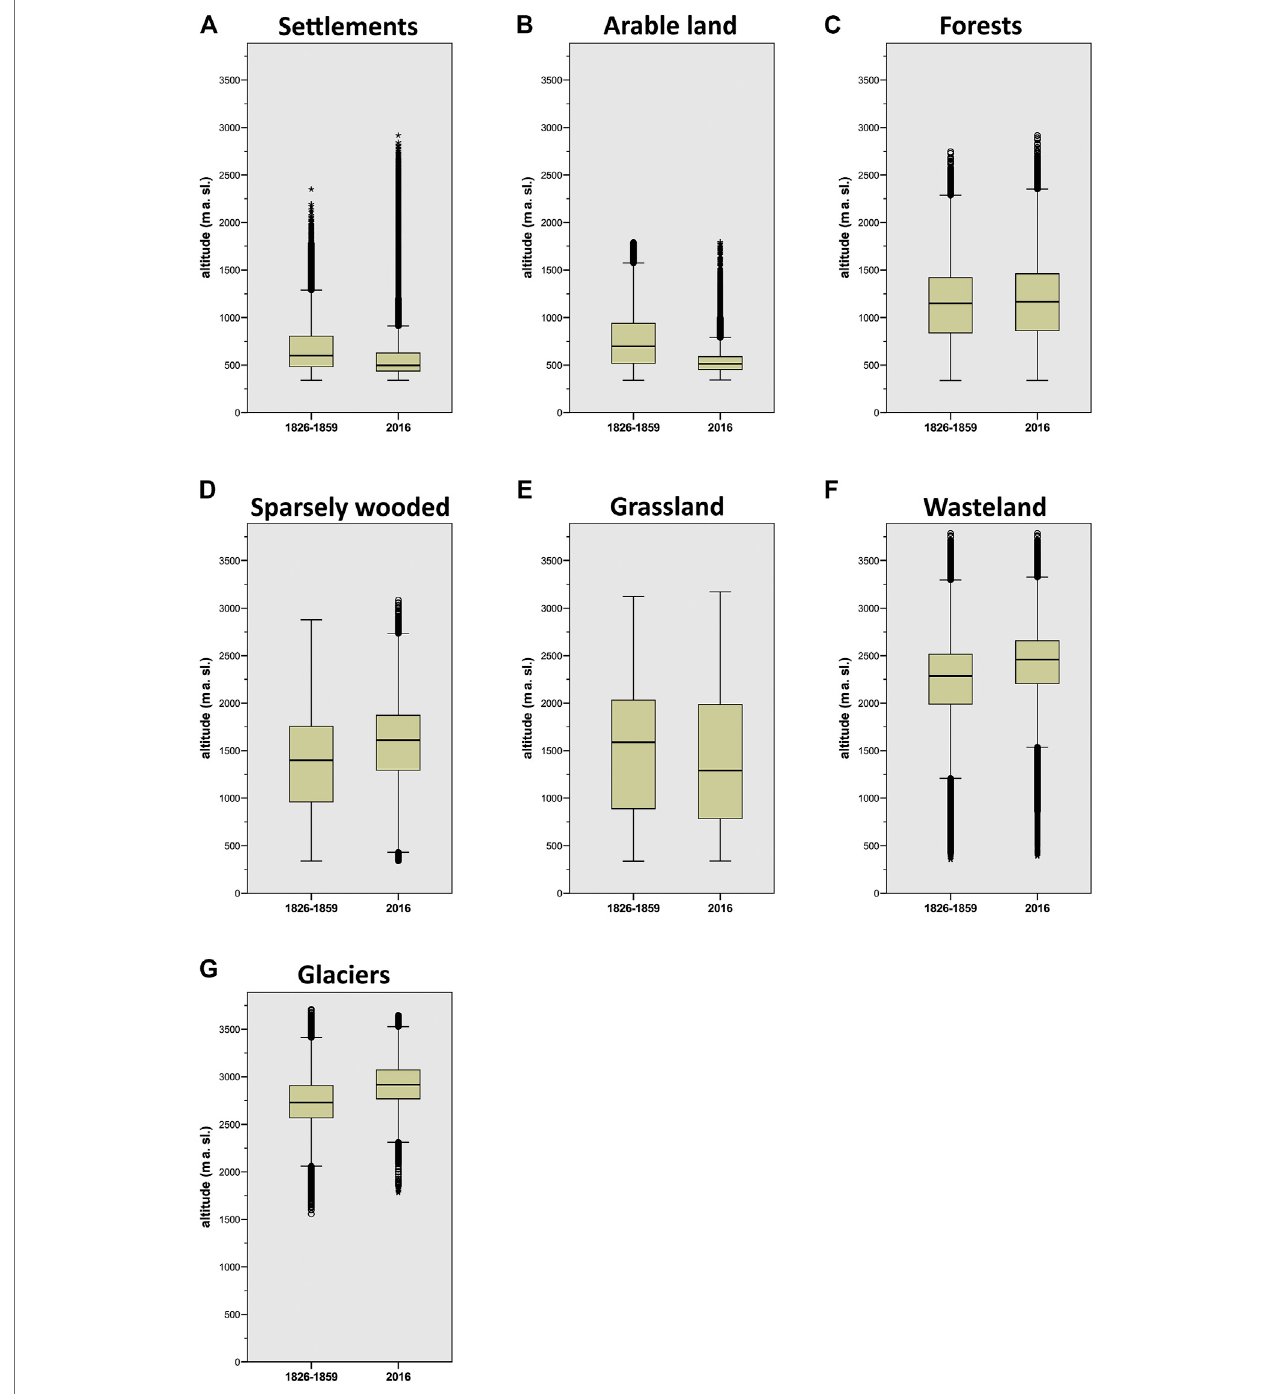
FIGURE 7 | Altitudinal distribution of (A) settlement areas, (B) arable land, (C) forests, (D) sparsely wooded areas, (E) grassland, (F) wasteland and (G) glaciers.